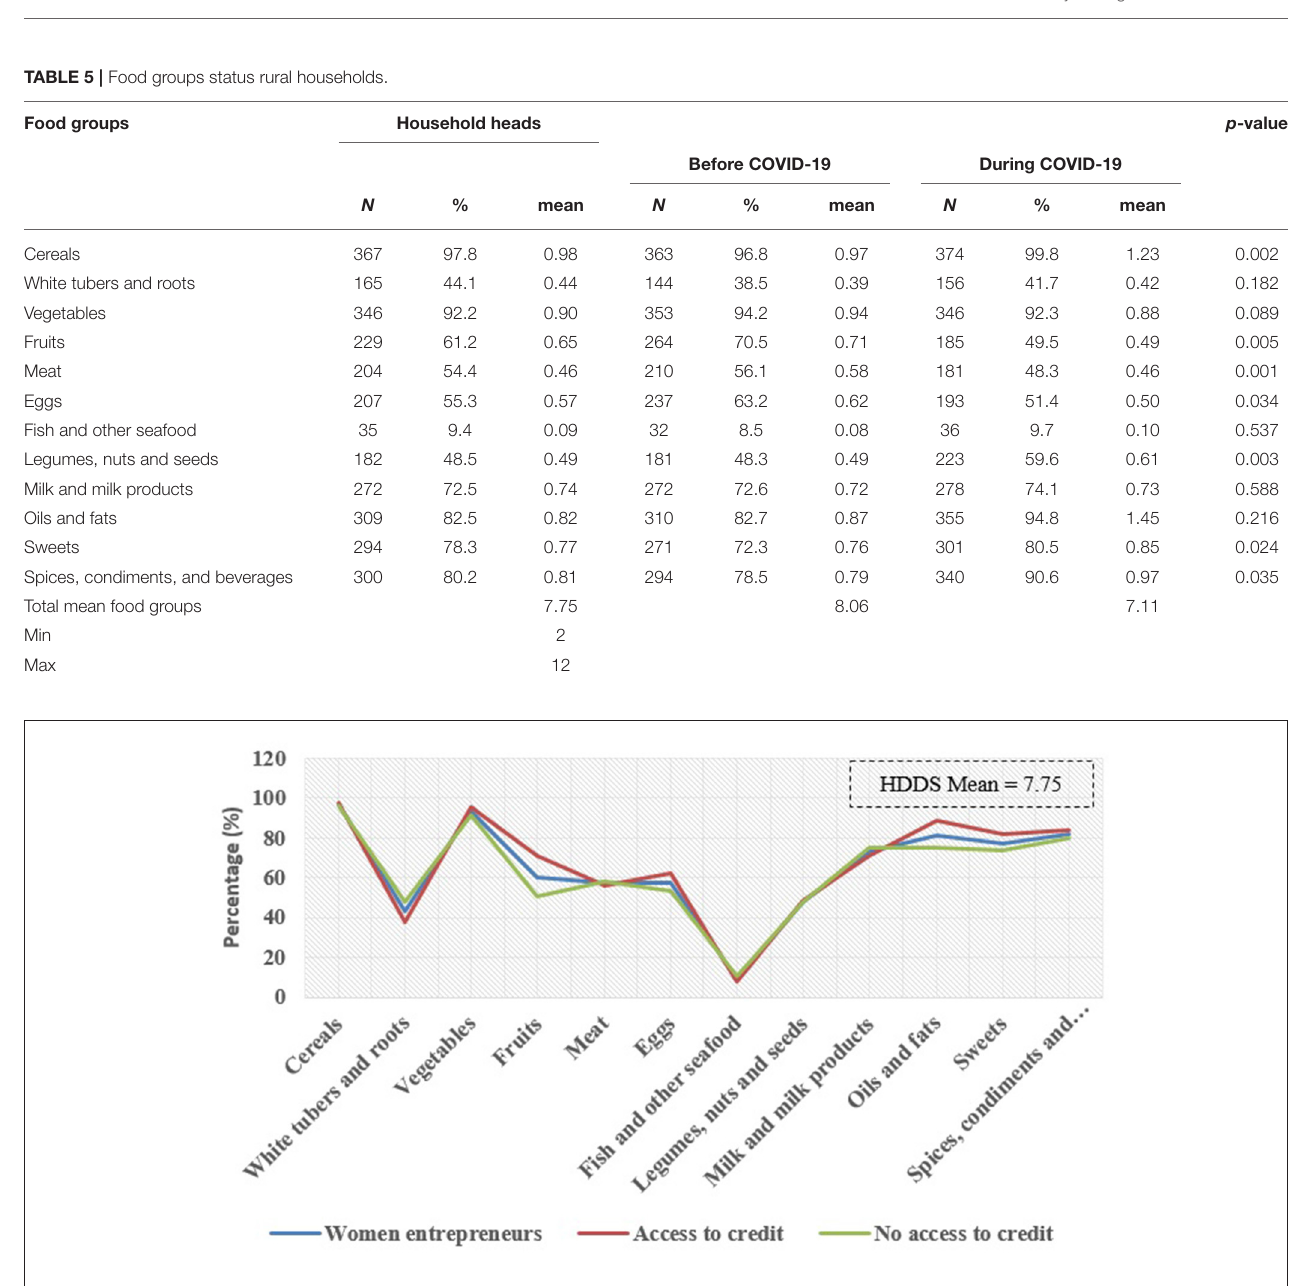
FIGURE 3 | Dietary diversity status of rural households before and after the COVID-19